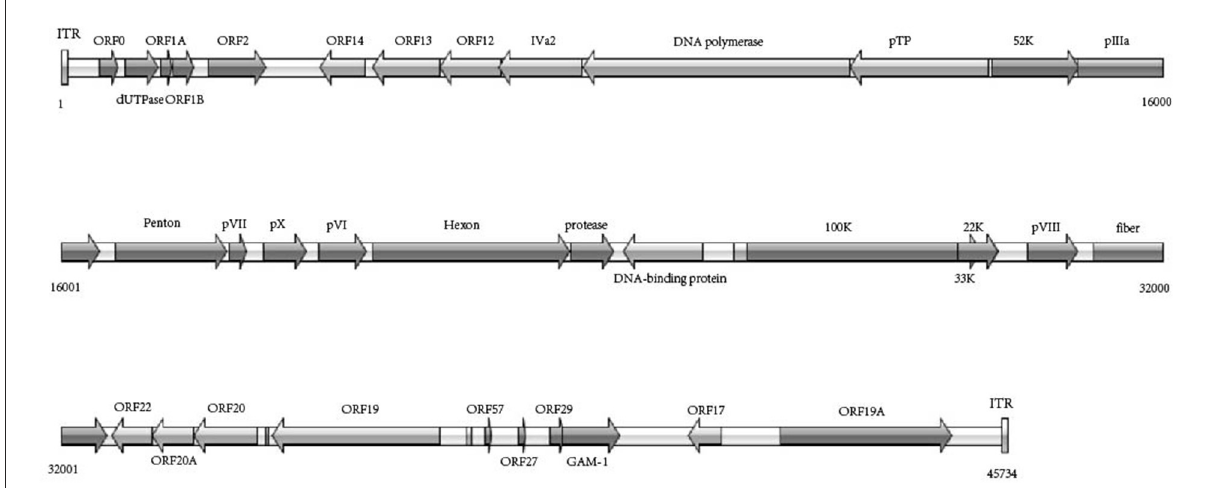
FIGURE4 Schematic representation of genome size and organization of the FAdV-5 strain WHRS.